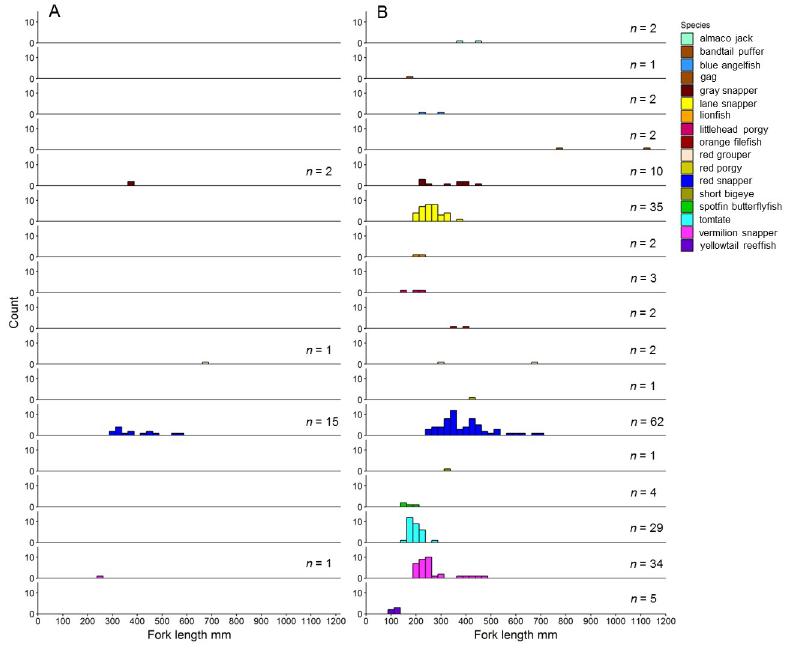
Fig 6. Field experiment frequency histograms. Frequency histograms (counts, 30 mm bins) of fork length estimates for 197 individuals among 17 species measured with a A) red laser scaler or B) stereo cameras with BD1 (406 mm) at reef sites (n = 20) surveyed in the northern Gulf of Mexico in 2018. The number of length estimates for each species is indicated on the right side of each panel.